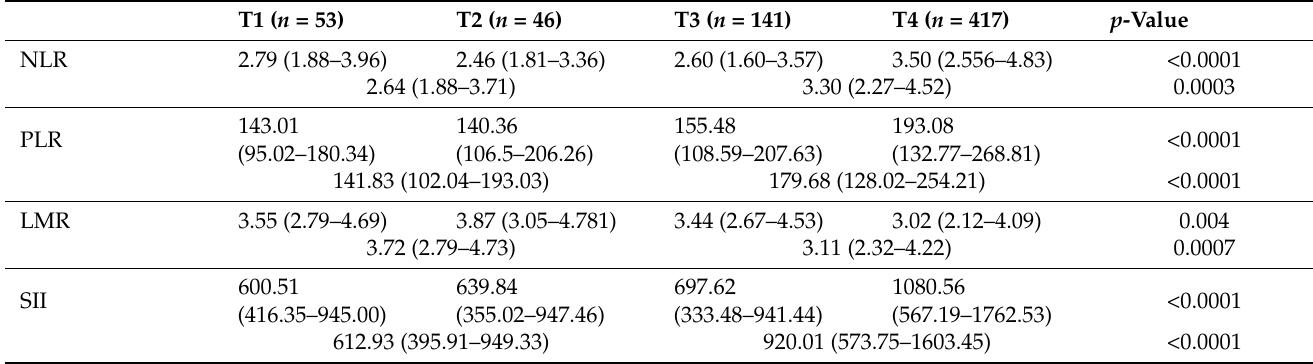
Table 3. Inflammatory biomarkers at presentation regarding T (tumor) stage ( n =